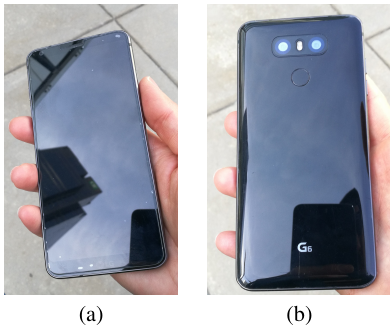
Figure 1. Smartphone LG G6: front (a) and rear view